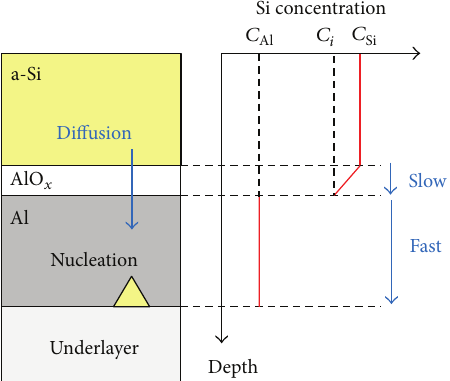
Figure 5: Schematic of Si heterogeneous nucleation during AIC with a vertical distribution of Si concentration in the sample. 𝐶 the atomic concentration in the a-Si layer, 𝐶 𝑖 is the Si concentration at the bottom of the AlO 𝑥 membrane, and 𝐶 in the Al layer. The crystal orientation of nuclei is determined by the interfacial energy between Si and the